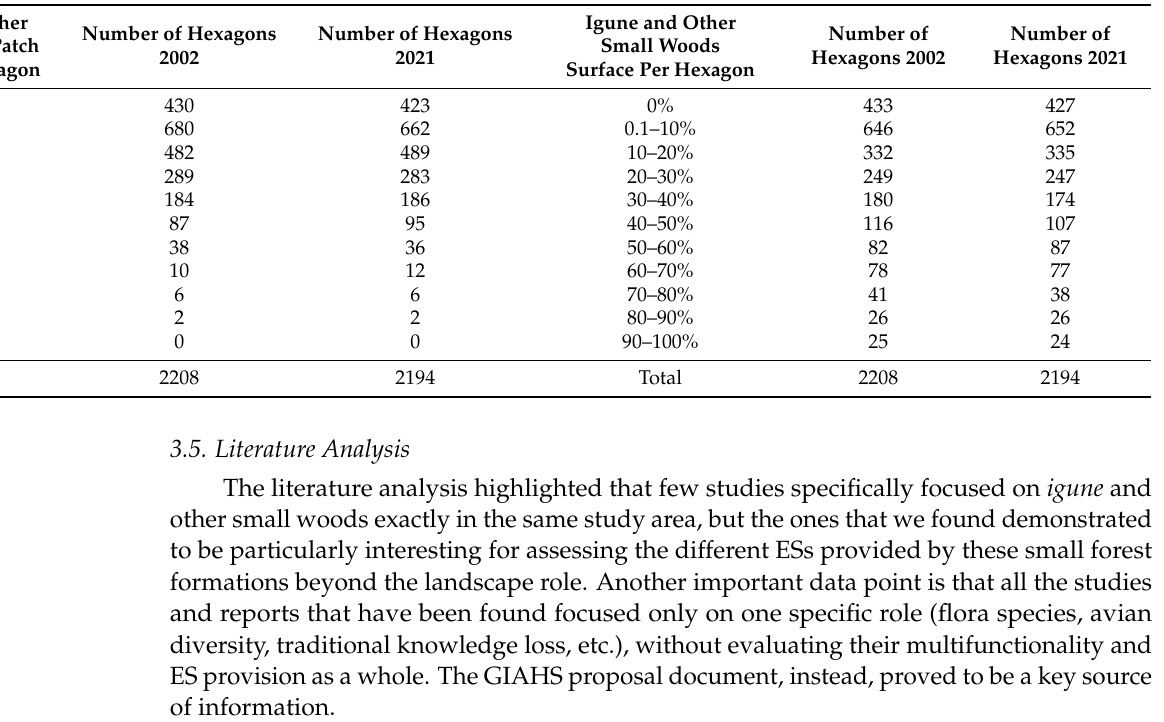
Table 4. Number of patches of igune and other small woods per hexagon and surface (in percentage on the total hexagon surface) occupied by igune and other small woods per hexagon for 2002 and 2021. It is possible to notice that the situation is almost